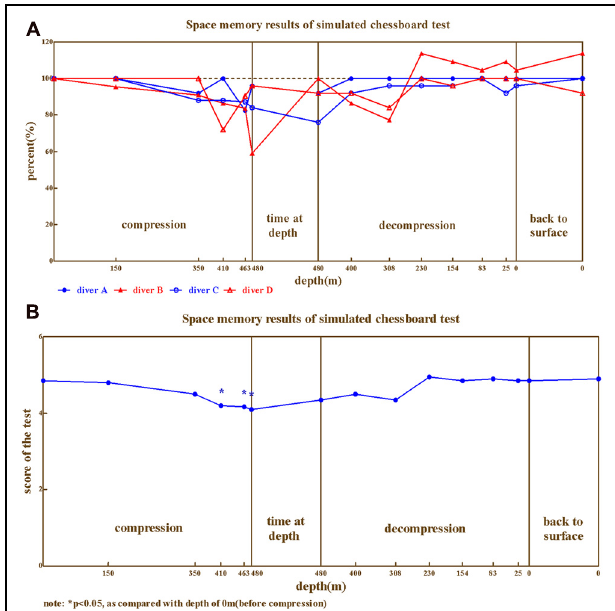
FIGURE 4 | The results from spatial memory. (A) Four divers, (B) Average.